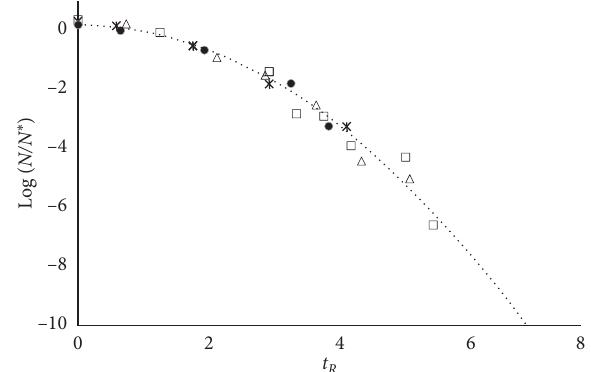
Figure 4: Master plot gathering the experimental data for E. coli (open squares), Listeria (stars), Salmonella (open triangles), and Staphylococcus aureus (full circles)